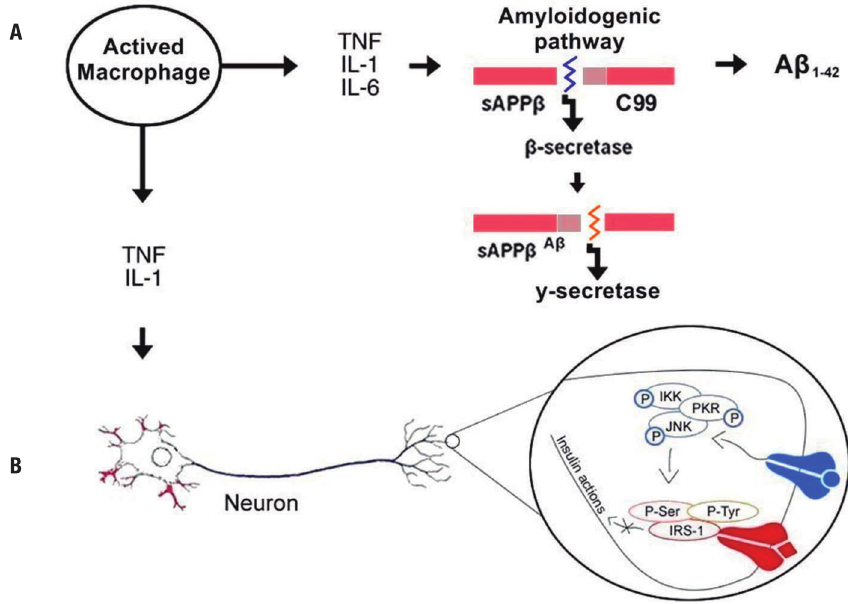
Figure 1. Inflammatory mediators contribute to increased β -amyloid production and reduced insulin activity. [A] Cytokines released by activated resident macrophages of the CNS (microglia) stimulates the amyloidogenic pathways of APP promoting an increase in β -amyloid levels in AD. Accumulation of A β together with inflammation induces oxidative stress and decreases brain insulin signaling 8 . [B] High accumulation of glucose and fat in peripheral blood induces the activation of immune cells such as macrophages. The proinflammatory cytokines released by these cells bind to their receptor located in neurons and promote the activation of molecules such as JNK leading to serine phosphorylation of the IRS-1 receptor, thereby triggering insulin resis- tance and blocking of insulin action in neuron cells. APP: amyloid precursor protein; A β : β -amyloid; C99: Protein C99; TNF: Tumour necrosis factor;